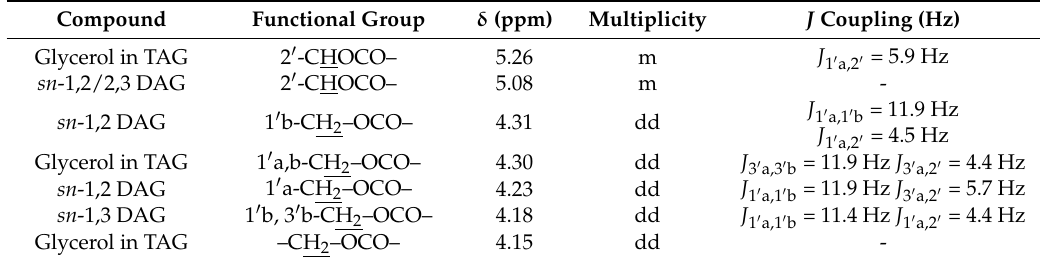
Table 6. 1 H-NMR resonance assignments of the glycerol moiety of lipids in CDCl 3 [59,60].